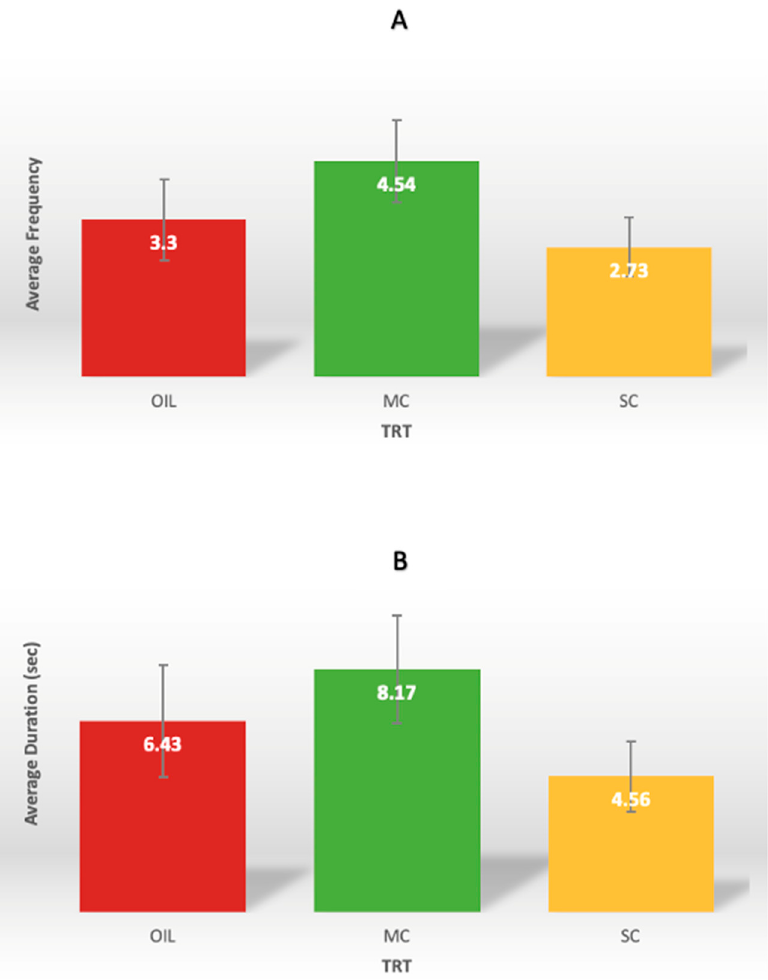
Figure 5. Average (±SE) frequency ( A ) and duration in seconds ( B ) of piglet purposeful investigations with environmental enrichment ropes on the first day of placement (Day 2 relative to farrowing). Ropes were dipped in one of three treatments: OIL = sunflower oil, MC = milky cheese, and SC = semiochemical. Frequency (Figure 5A; p = 0.20) and duration (Figure 5B; p = 0.21) of interactions was not different between treatments.